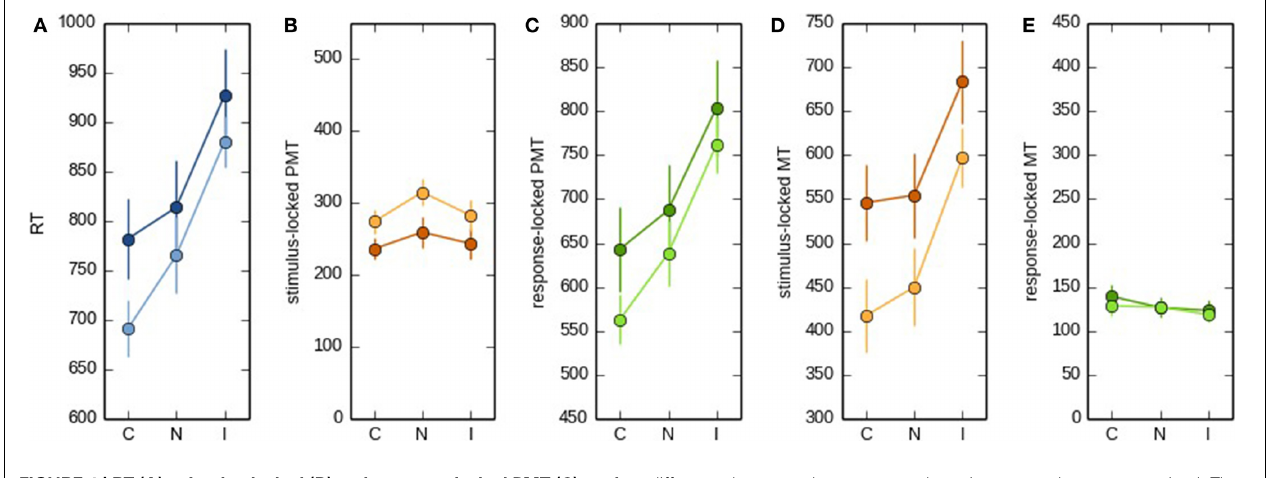
difference between the two onset-detection approaches were maximal. The condition effects depicted by the light lines are based on the broader data set. For the sake of comparison, the scale on the y axis is kept constant across (B,C) and (D,E)